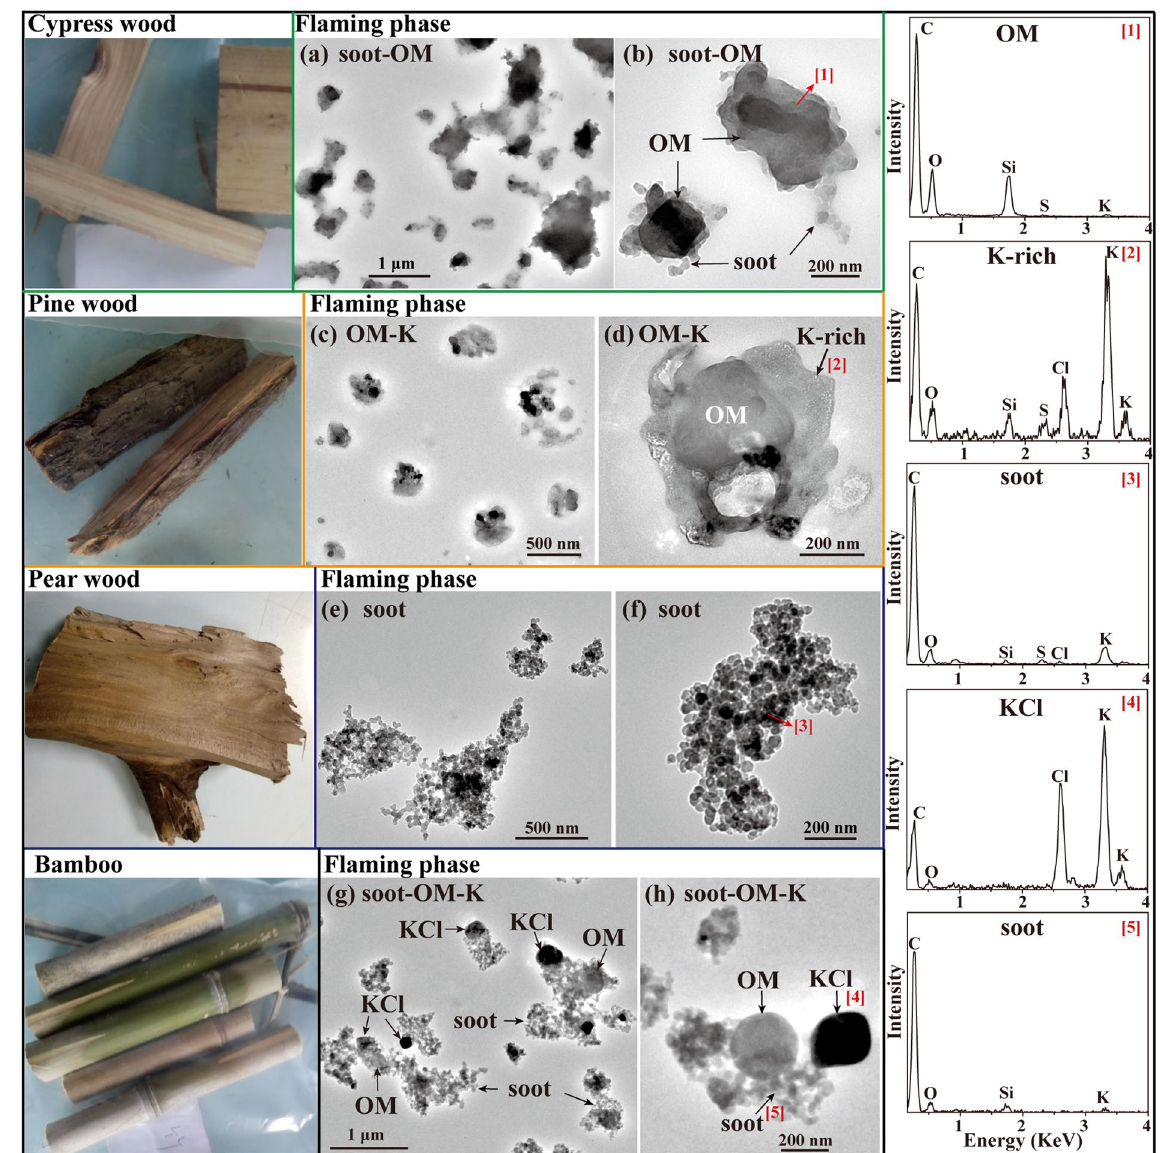
Figure 7. TEM images and EDS spectra of individual primary particles from the combustion of cypress, pine, and pear wood, and bamboo. Low magnification and high resolution TEM images of ( a and b ) irregular OM- soot particles from cypress wood, ( c and d ) OM-K particles from pine wood, (e and f) bare cluster-like soot particles from pear wood, and ( g and h ) cluster-like soot particles internally mixed with KCl and spherical OM from bamboo, in the flaming phase, respectively. The corresponding EDS spectra are indicated by the number in square